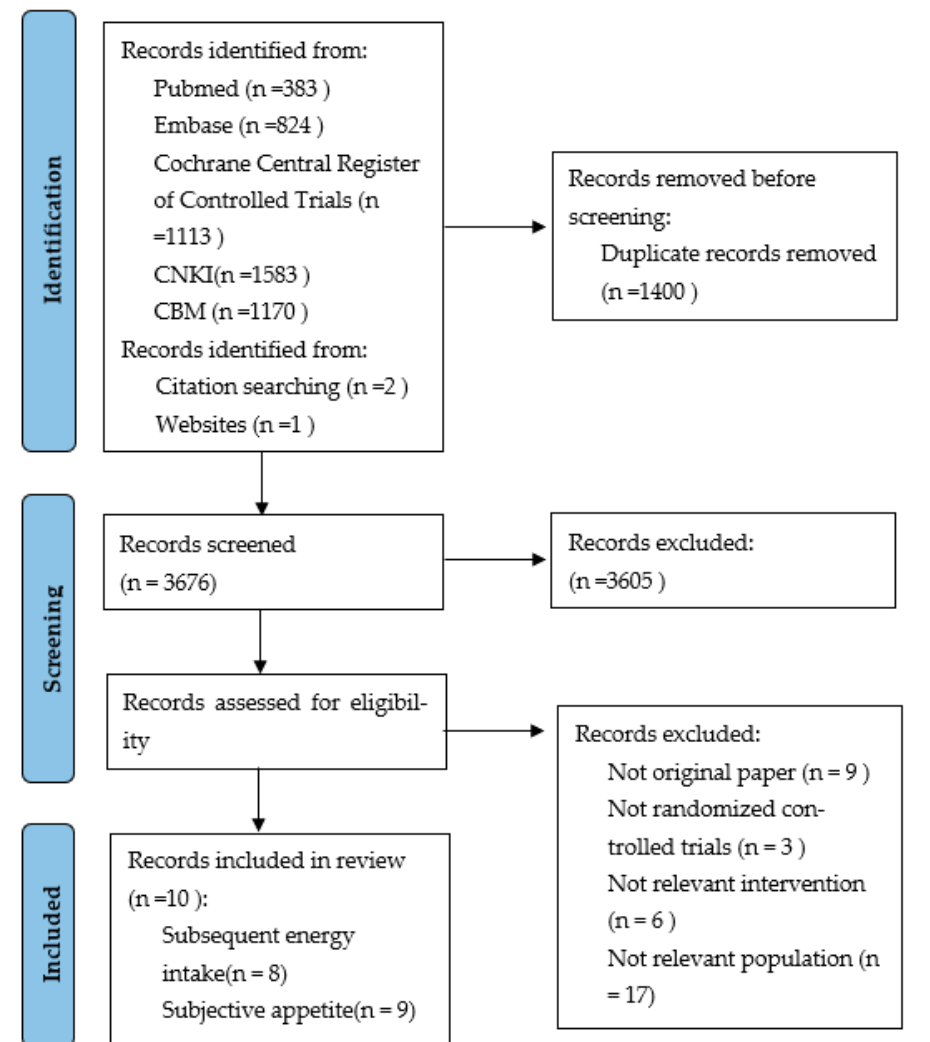
Figure 1. Flow diagram of the literature search process.